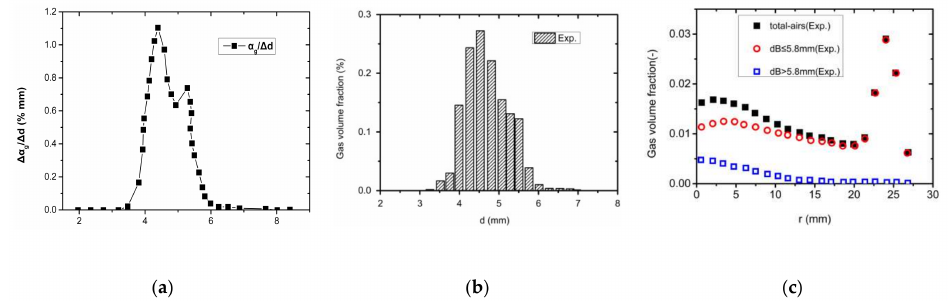
Figure 15. Distribution of gas volume fraction of bubbles with different diameters (Exp. Dat [52]) ( a ) Distribution of bubble diameters (left). ( b ) Histogram of bubble diameter distribution (middle). ( c ) Distribution of gas volume fraction along the radius